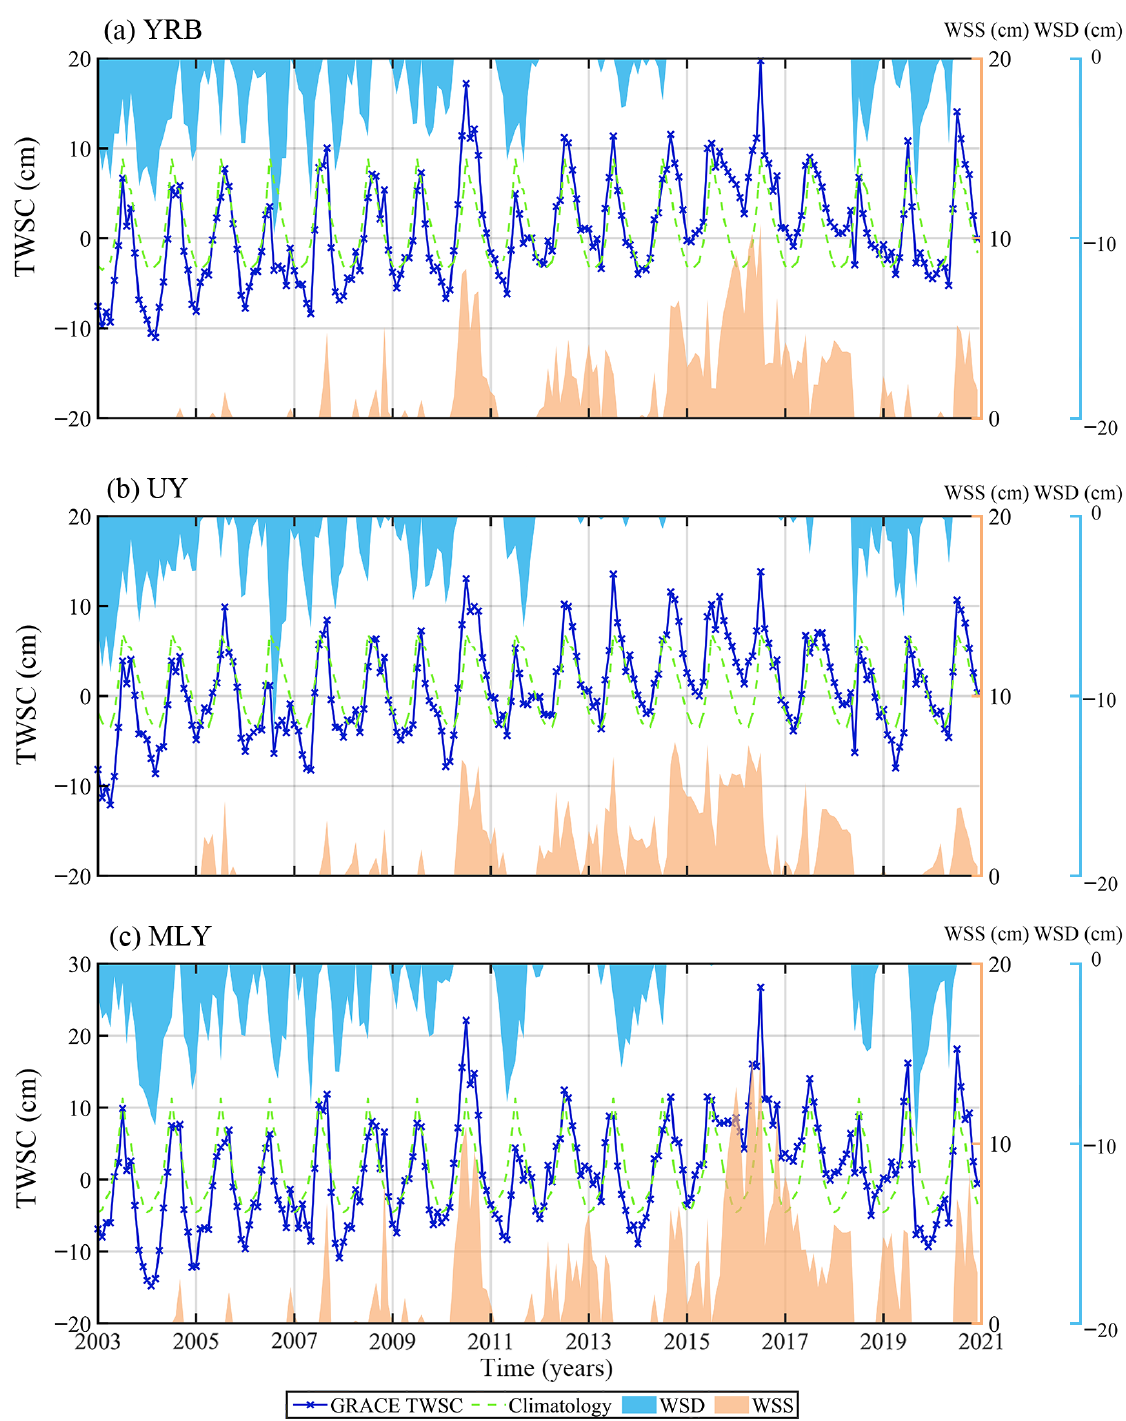
Figure 5. The time series of GRACE TWSC, water storage deficit, and surplus in YRB, UY, and MLY. Navy blue lines: monthly GRACE TWSC, green dotted line: month climatology, light blue shaded regions: water storage deficit, and orange shaded regions: water storage surplus.